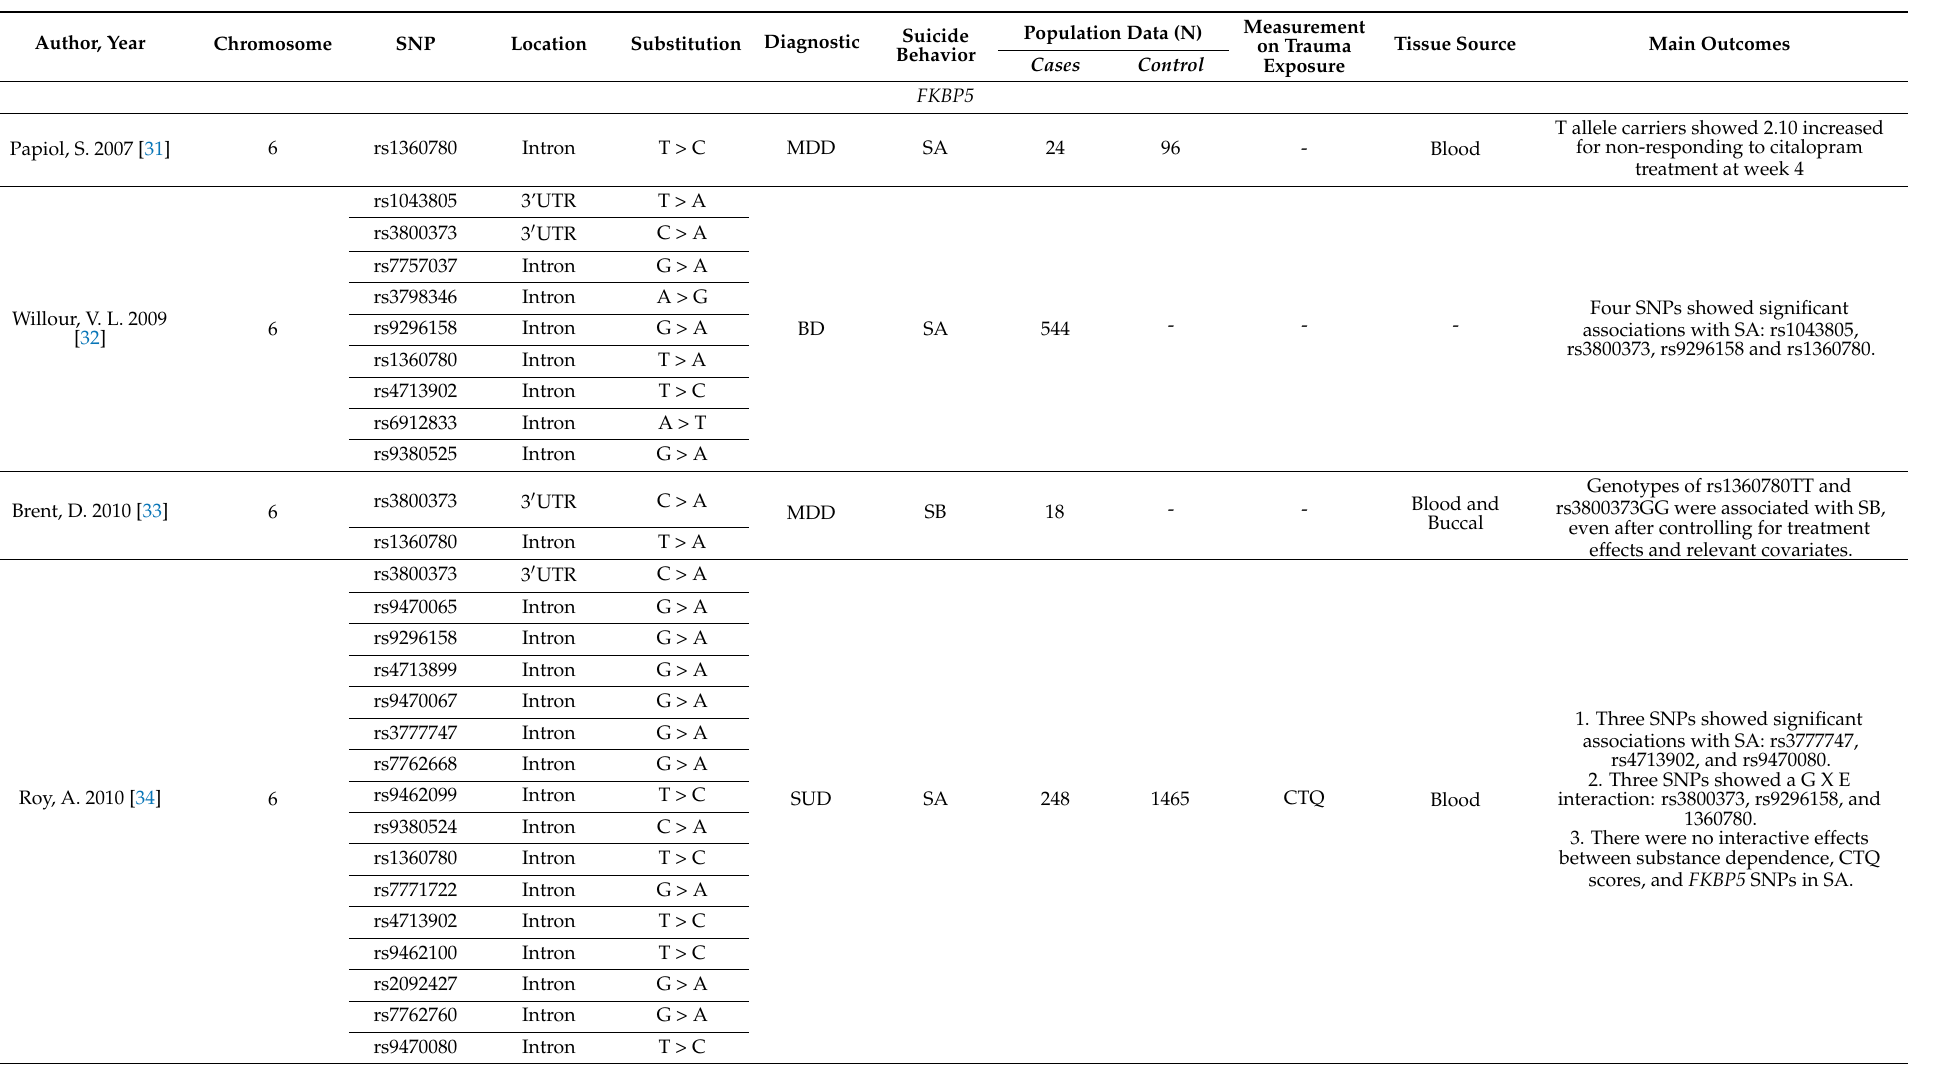
Table 1. Detailed analysis of the selected publications regarding the association between single-nucleotide polymorphisms (SNP) in HPA genes and the pathogenesis of suicide